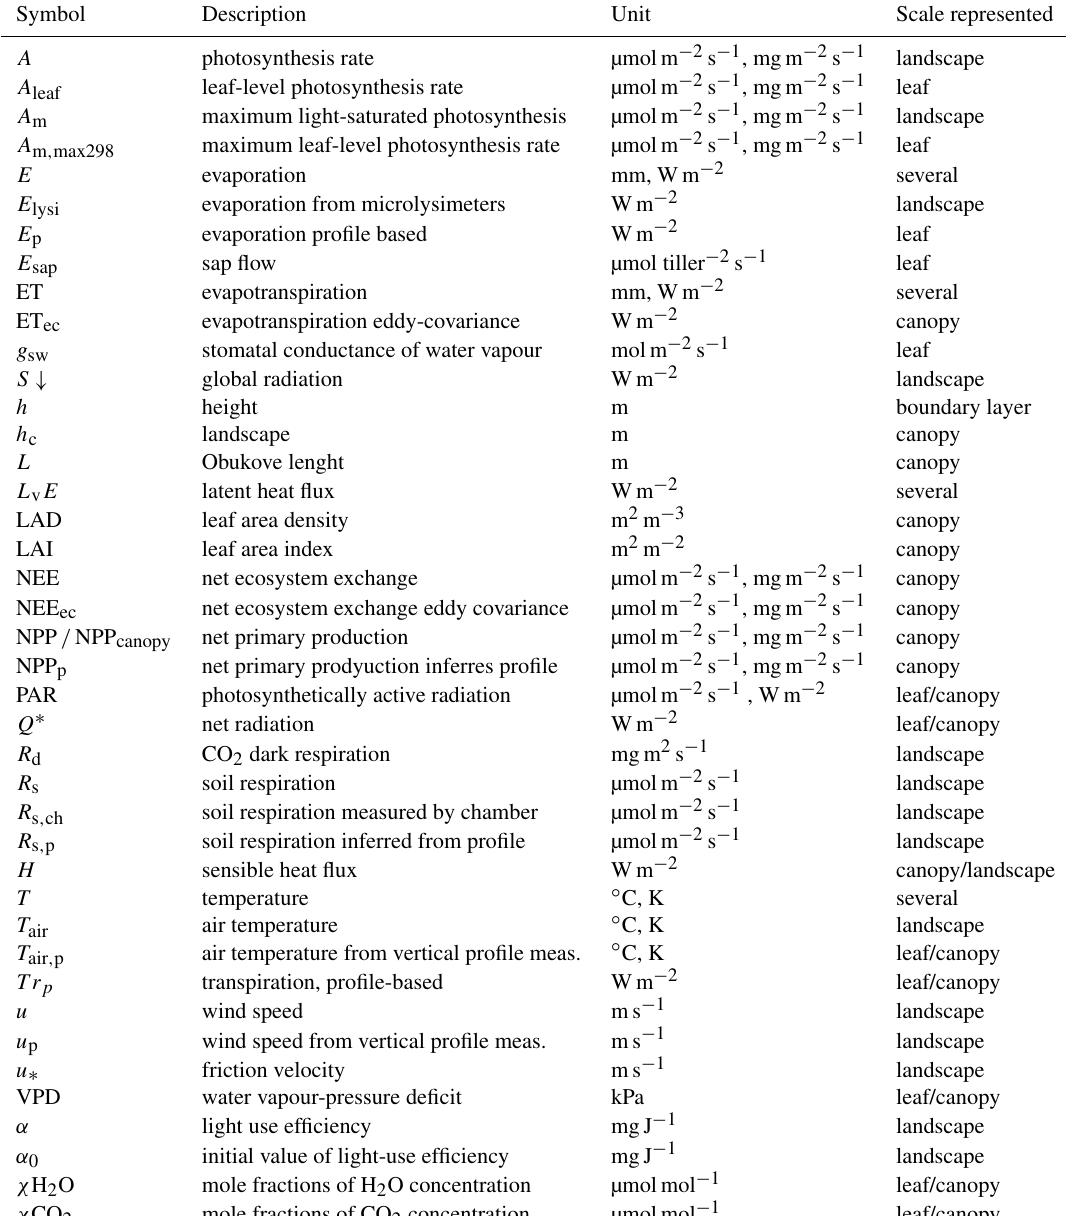
Table 2. List of symbols, description, units, and the representative scale.